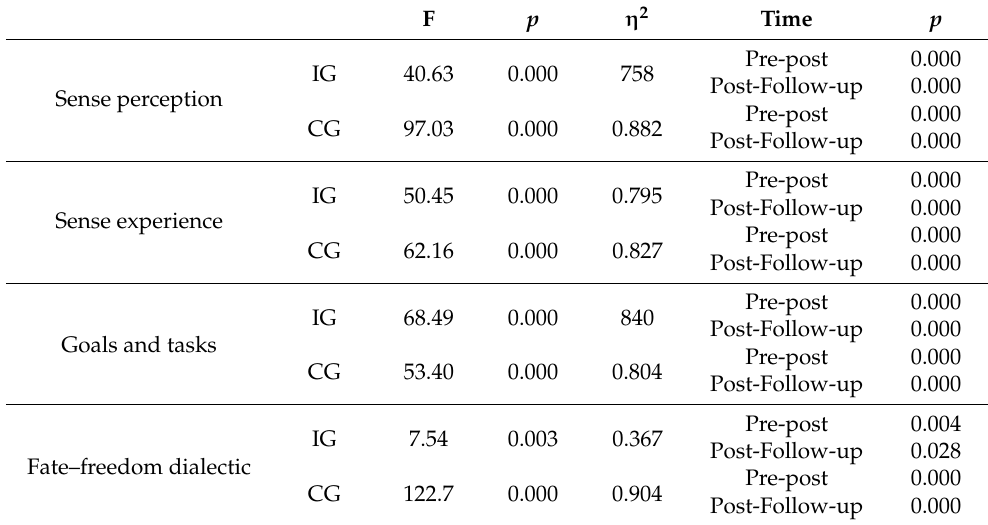
Table 4. Univariate analysis of the evolution of the groups independently over time.